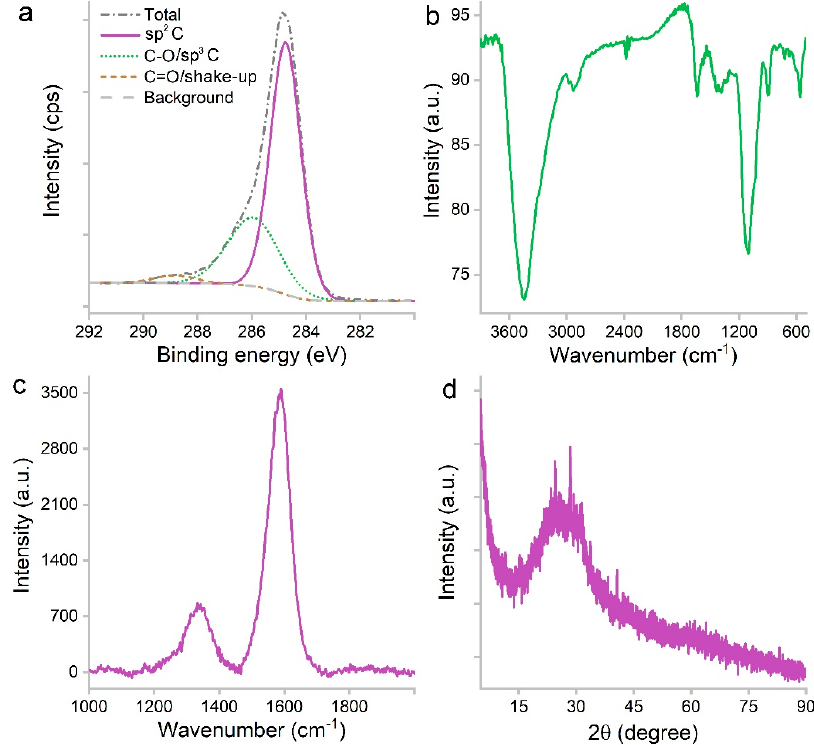
Figure 3. C1s XPS ( a ), IR ( b ), Raman ( c ) and XRD ( d ) spectra of PCS.